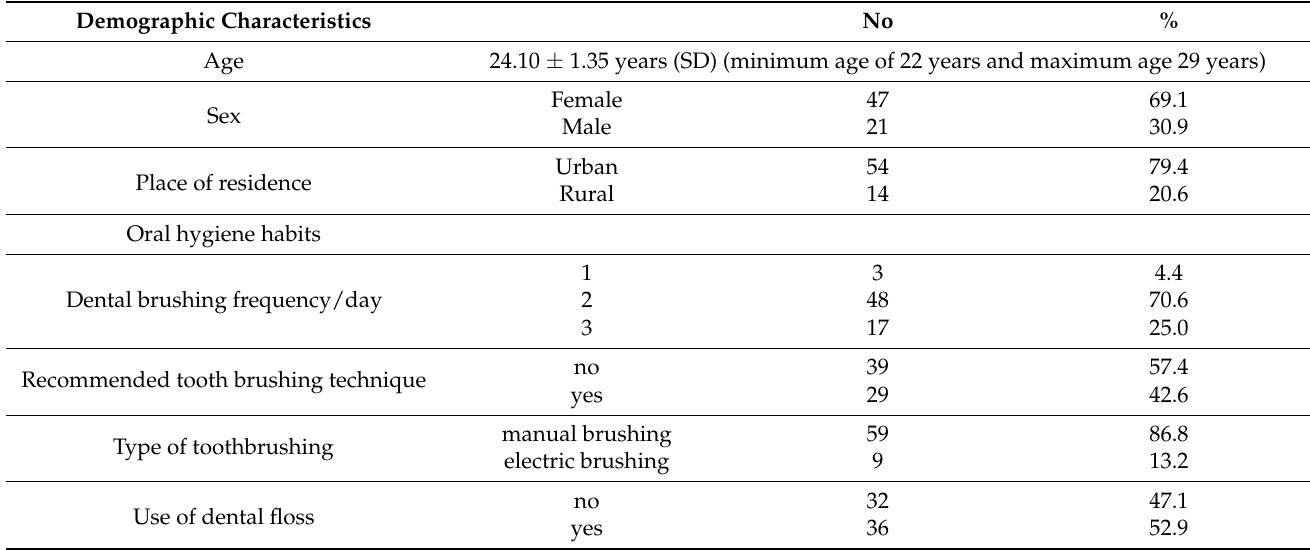
Table 1. Demographic characteristics and oral hygiene habits of the participants. Demographic